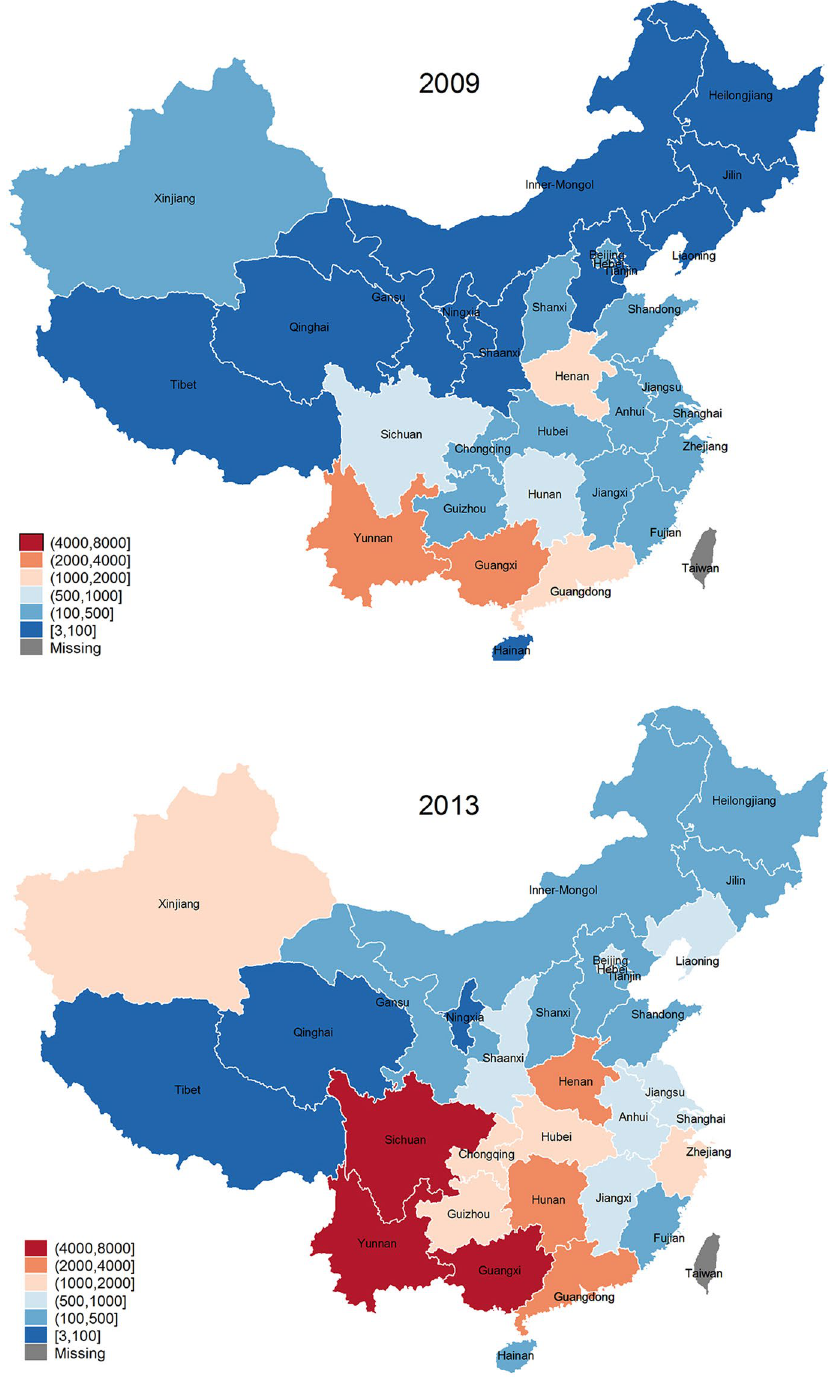
Figure 1. Yearly HIV/AIDS incidence in China by province in 2009 and 2013. The yearly incidence data is calculated by summing up the monthly incidence in 2009 and 2013 from the CDC -reported incidence records for each province. To show the trend of provincial HIV/AIDS incidence from 2009 to 2013, we use the “spmap” command in STATA14.0 to draw the map 27